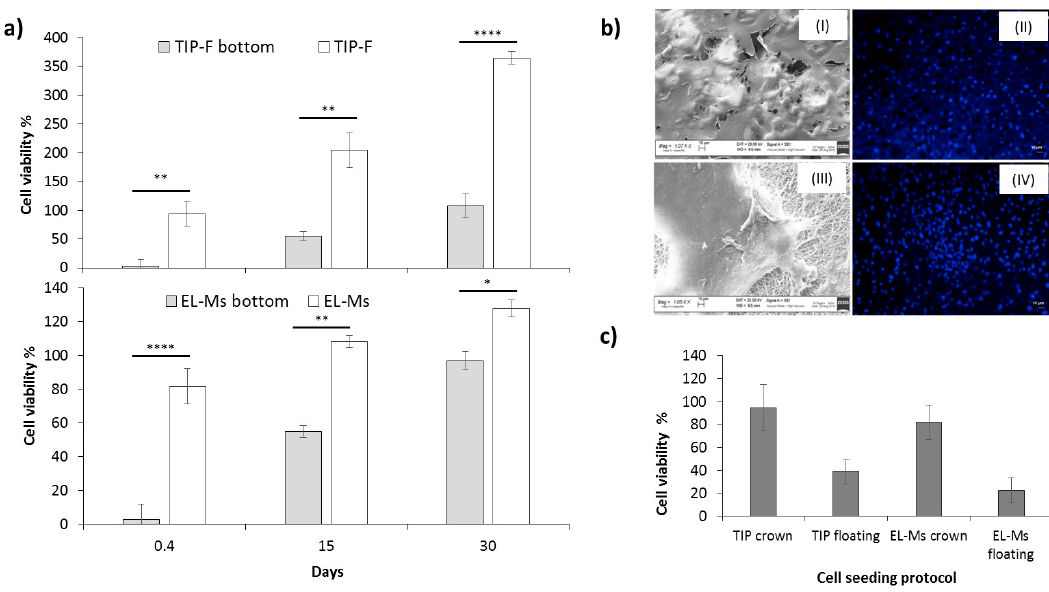
Figure 7. ( a ) Cell viability percentages of TIP-Fs and EL-Ms after incubation with p-MSCs for 0.4, 15, and 30 days and ( b ) cell adhesion of p-MSCs on TIP-Fs and EL-Ms as a function of di ff erent cell seeding protocols. ( c ) Cell characterization by SEM and CLSM: SEM ( I ) and confocal ( II ) images of p-MSCs after incubation on TIP-F for 30 days; SEM ( III ) and confocal ( IV ) images of p-MSCs after incubation on EL-Ms for 30 days. Confocal analyses have been carried out after DAPI staining. Magnification SEM analysis 1.07 kX. A probability value less than 0.05 (* p < 0.05) was defined to be significant